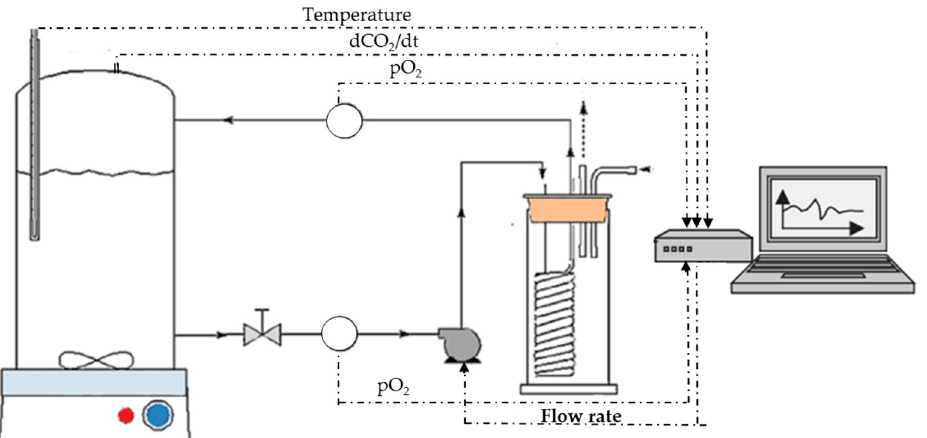
Figure 5. Schematic representation of the bubble-free micro-oxygenation system. Oxygen is added by diffusion across a silicone tubing membrane with a controlled oxygen transfer rate (OTR). The OTR is modulated by controlling the liquid flow rate inside the silicone tube.